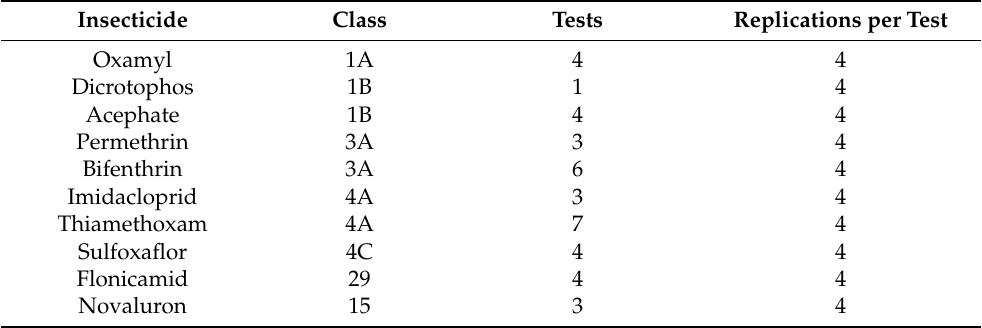
Table 1. List of insecticide treatments used for the impact of tarnished plant bug behavior in laboratory bioassays in